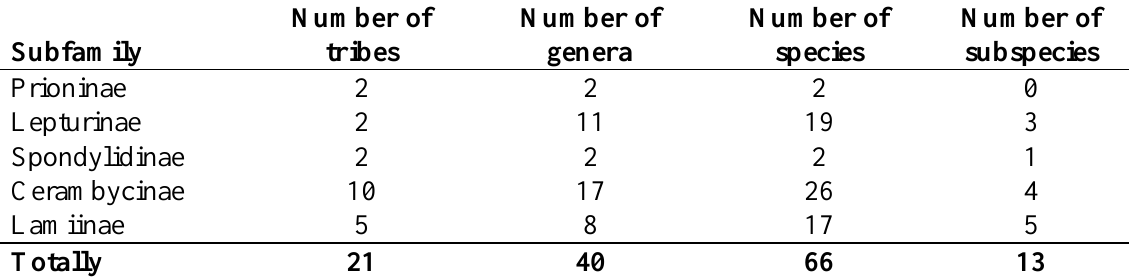
Table 1. Total number of longhorn beetle taxa in the City of Kragujevac and numbers of the taxa within